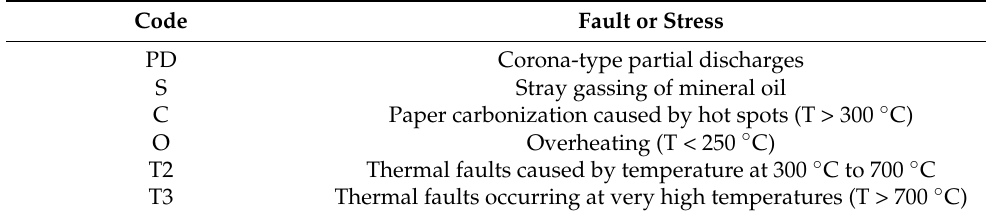
Table 6. Defining the fault areas in the